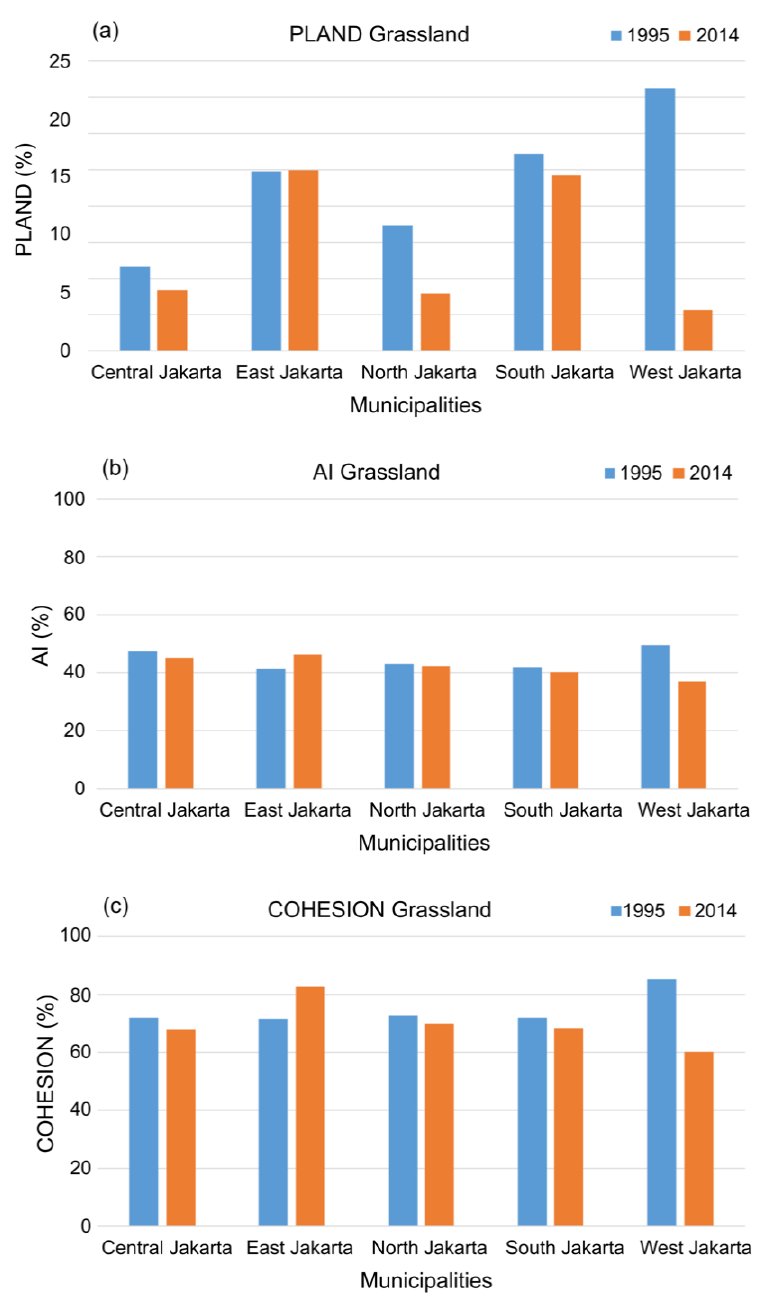
Figure 7. Landscape metrics of grassland. ( a ) Land proportion; ( b ) aggregation index; ( c ) cohesion. Moreover, the landscape patterns of cropland were also subject to dynamic changes due to urbanization, as shown in Figure 8. In 1995, the highest proportion of cropland was mainly observed in North Jakarta, East Jakarta, and West Jakarta. The highest cropland proportion of 15.9% was observed in North Jakarta, while the lowest cropland proportion of 2.3% was observed in Central Jakarta. Meanwhile, the cropland distribution in the four municipalities exhibited a scattered pattern, as indicated by the AI percentage. For in- stance, cropland in Central Jakarta, East Jakarta, and South Jakarta was below 50%. More- over, the connectivity of crops was high in North Jakarta, West Jakarta, and East Jakarta, where the COHESION was 95.3, 87.9, and 84.6%, respectively.